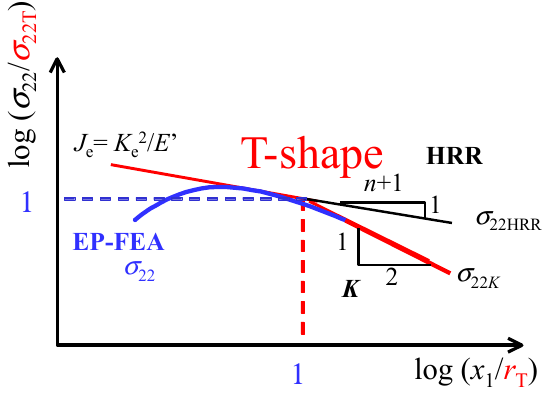
Figure 1. Explanation of the T-scaling method, which is a stress-distribution scaling method under small-scale yielding conditions [45].